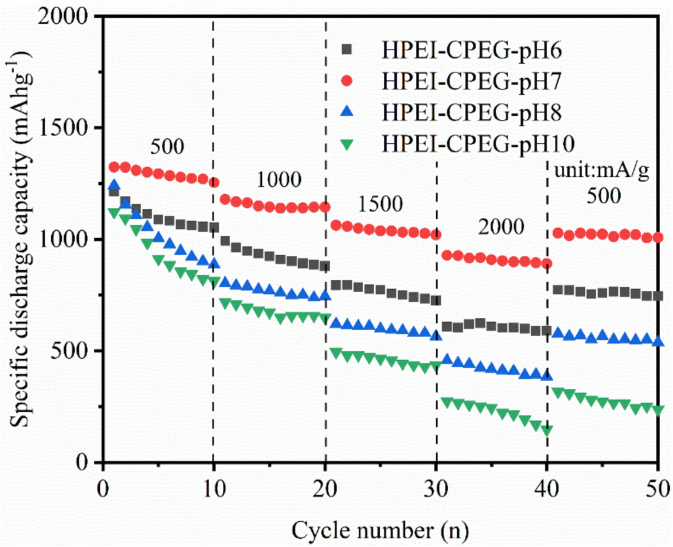
Figure 7. Cycle performance of Si anode with HPEI-CPEG-pH6, HPEI-CPEG-pH7, HPEI-CPEG-pH8, and HPEI-CPEG-pH10 binders at various charge/discharge